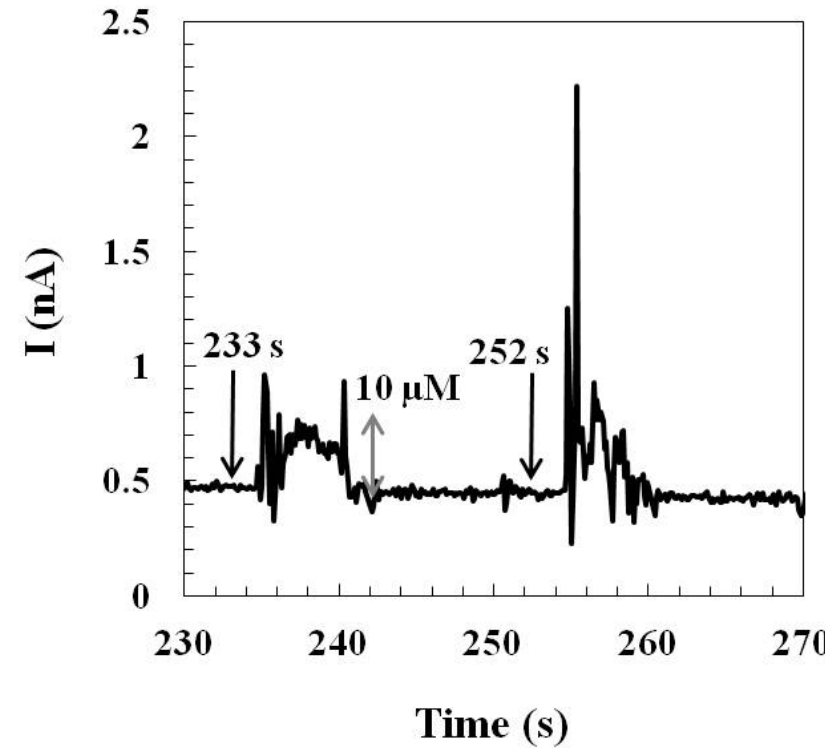
Figure 5. A representative result of the stress-induced glutamate sensing current corresponding to the glutamate release in the hypothalamus of an awake, freely moving rat. Arrows indicate the timing of each tail pinch. A calibration bar ( gray double-sided arrow ) is shown on the plot. The calibration bar was determined by the slope of the post-calibration curve of each implanted glutamate